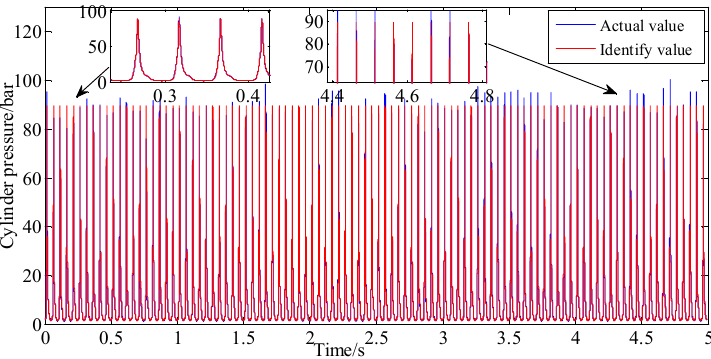
Figure 16. Pressure identification at A / F ratio 0.95.